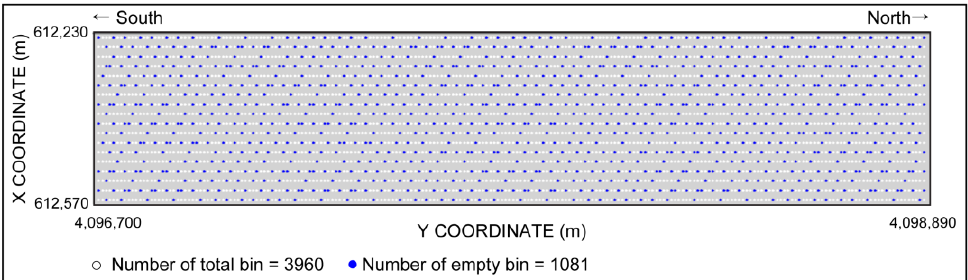
Figure 12. C3DS bin fold map after matching to the H3DS data. Blue dots show the location of empty bins, which are interpolated via surrounding traces.